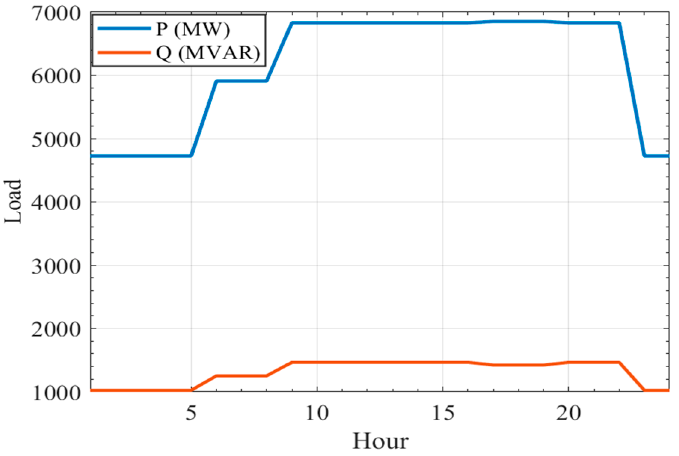
Figure 12. Variations in the P and Q of the IEEE 118-bus system.